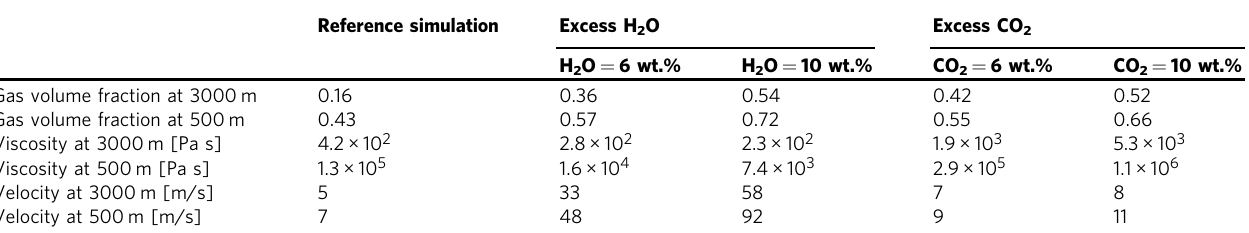
Table 2 Gas volume fraction, viscosity and velocity values at selected depths resulting from the reference simulation and from both the excess H 2 O and CO 2 runs.